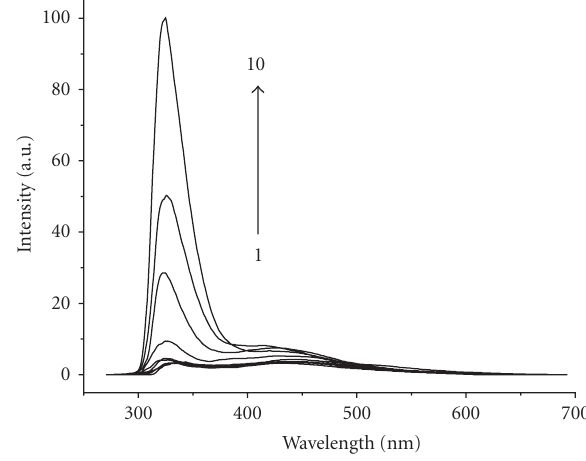
Figure 1: The fluorescence spectra of IV in ethanol at di ff erent tem- peratures: 1(294), 2(273), 3(252), 4(231), 5(214), 6(203), 7(174), 8(152), 9(135), and 10(115K). λ exc = 288nm.